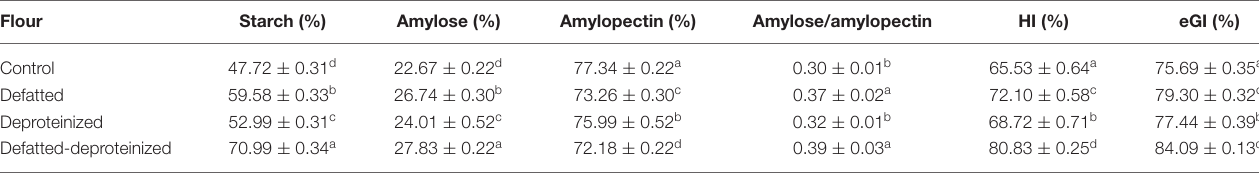
TABLE 3 | Starch, amylose, amylopectin, starch hydrolysis index (HI), and estimated glycemic index (eGI) of control, defatted, deproteinized, and defatted-deproteinized sorghum flour. Flour